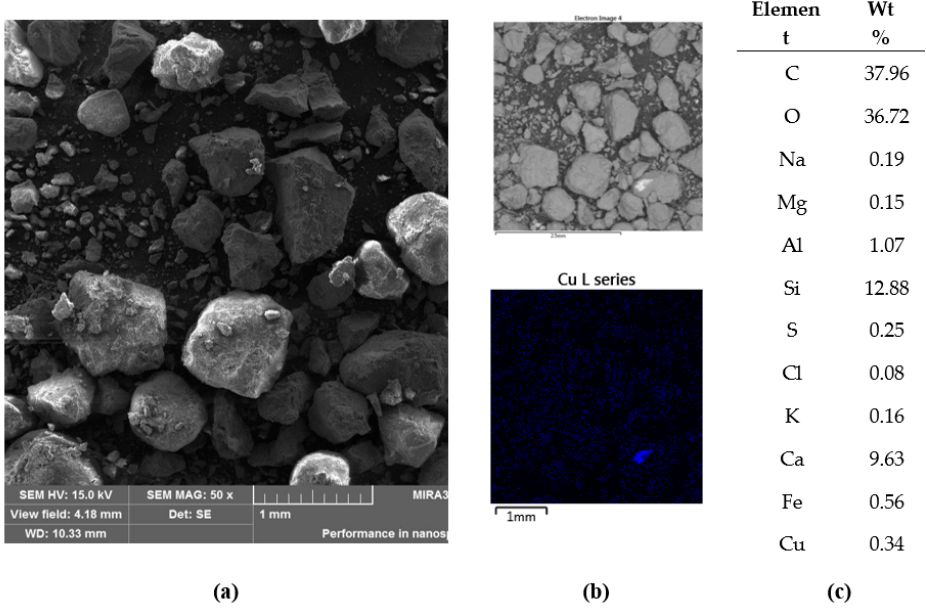
Figure 14. Crushed concrete on carbon tape, specimen 4: ( a ) SEM-SE image; ( b ) SEM-BSE image, with a map of Cu location, and ( c ) the elemental content over the whole shown area.